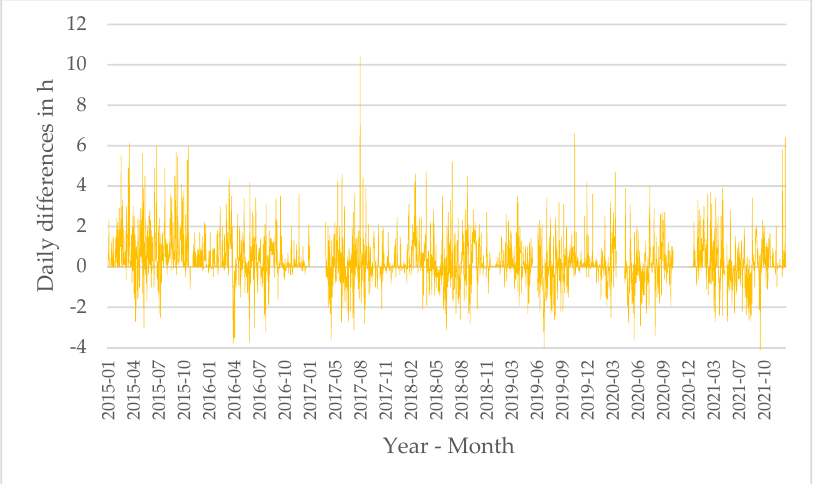
Figure 4. Differences in daily sunshine duration (automatic minus manual measurements) in Borucino, 2015–2021.